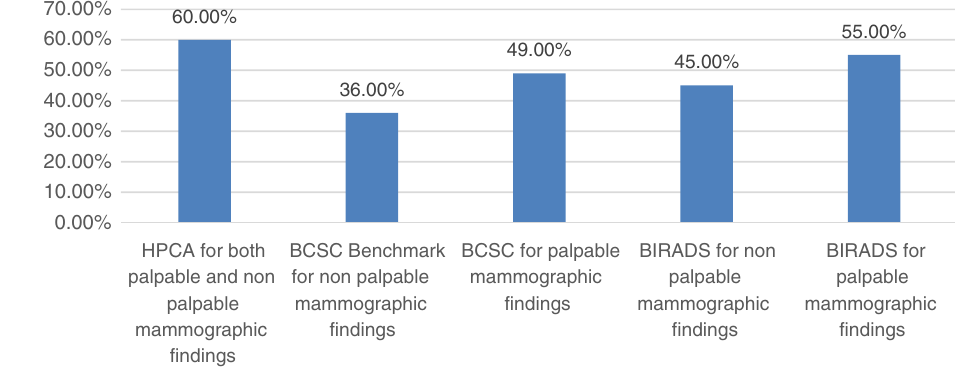
Fig. 3 PPV3 showing how frequently performed biopsies indicated cancers